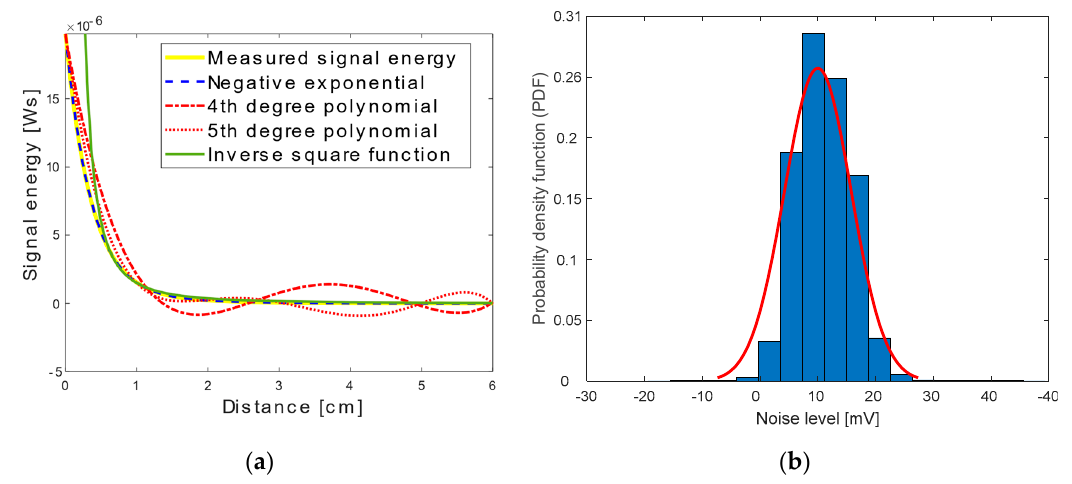
Figure 3. Characteristics of a light emitting diode (LED) photodetector: ( a ) received signal energy decay with increasing distance; ( b ) histogram of LED photodetector noise signal and its fitting to a Gaussian function.